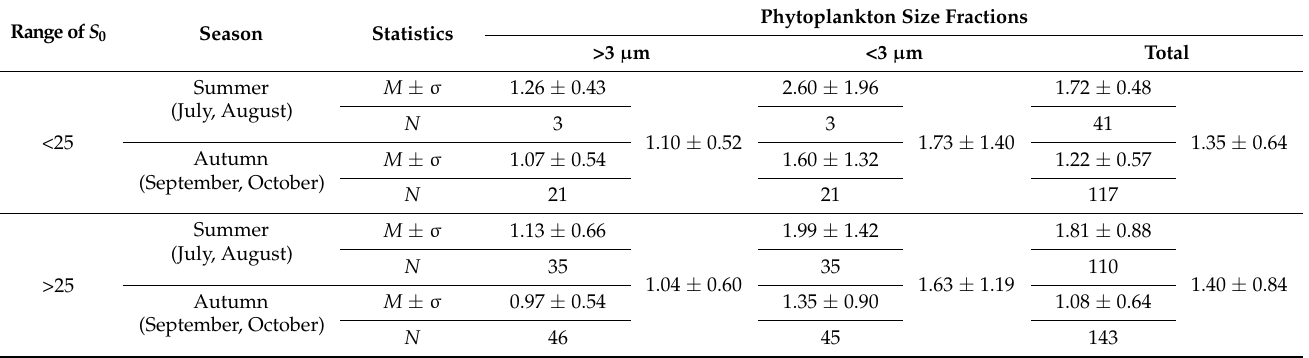
Table 3. The optimal assimilation number (mgC (mgChl a )) –1 h –1 of different phytoplankton size groups within the different salinity ranges and seasons. S 0 —sea surface salinity; M —mean; σ —standard deviation; N —number of